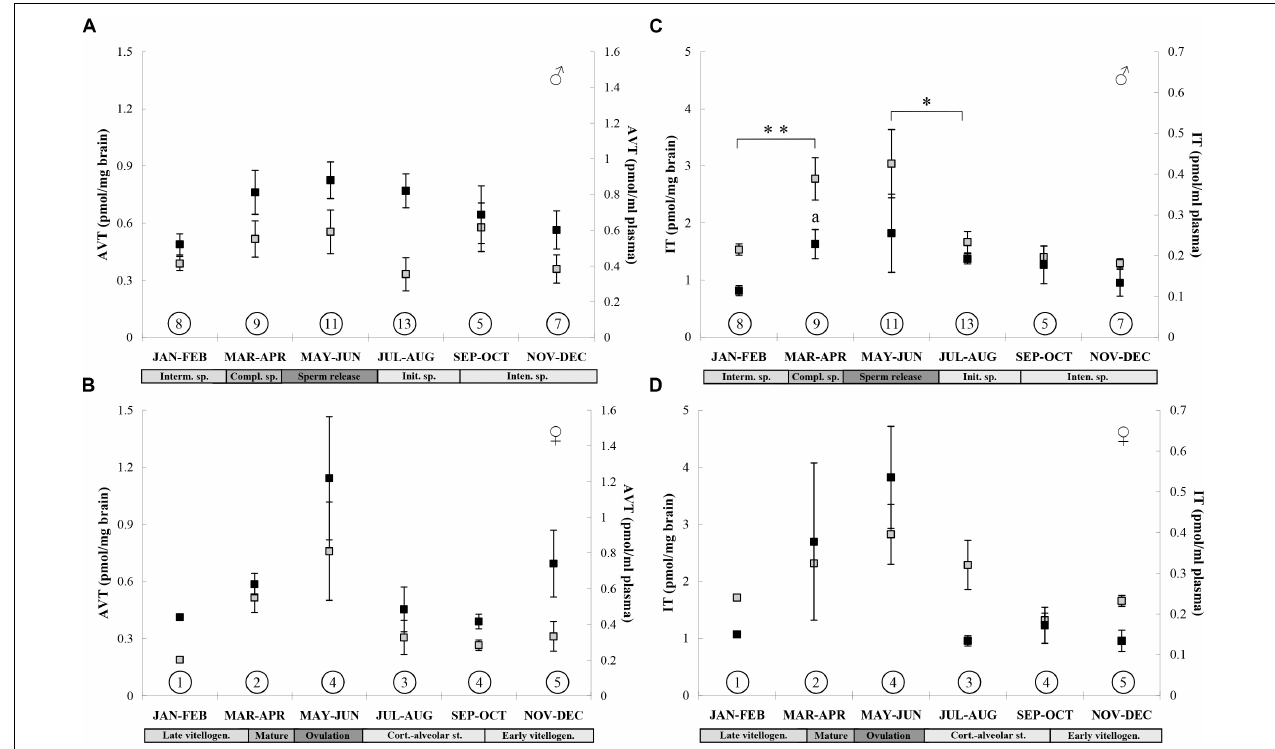
FIGURE 2 | Seasonal changes in brain (black squares) and plasma (gray squares) AVT concentration in males (A) and females (B) , and IT concentration in males (C) and females (D) of the round goby. Values are presented as means ± SEM. Number of sampled fish is given in the circles. Significant differences between brain values are indicated as a: P < 0.05 vs. Interm. sp. (JAN-FEB) and between plasma values are indicated as: * P < 0.05, ** P < 0.01 (one-way ANOVA followed by Tukey’s post-hoc test). Reproductive phases are shown below months: males: Interm. sp., intermediate spermatogenesis; Compl. sp., completed spermatogenesis (pre-spawning phase), Sperm release (spawning phase); Init. sp., initial spermatogenesis; Intens. sp., intensive spermatogenesis; females: Late vitellogen., late vitellogenic stage (pre-spawning phase), Ovulation (spawning phase), Cort.-alveolar st., cortico-alveolar stage; Early vitellogen., early vitellogenic stage.